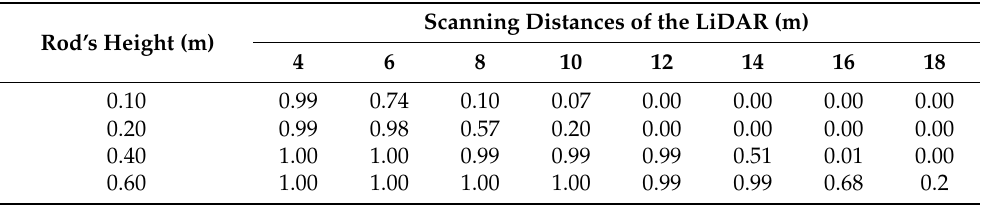
Table 2. Probability of the LiDAR detecting target rods of different heights at scanning distances of 4–18 m. A total of 20 rods at each height were scanned by the LiDAR at each distance. Rod’s Height (m)